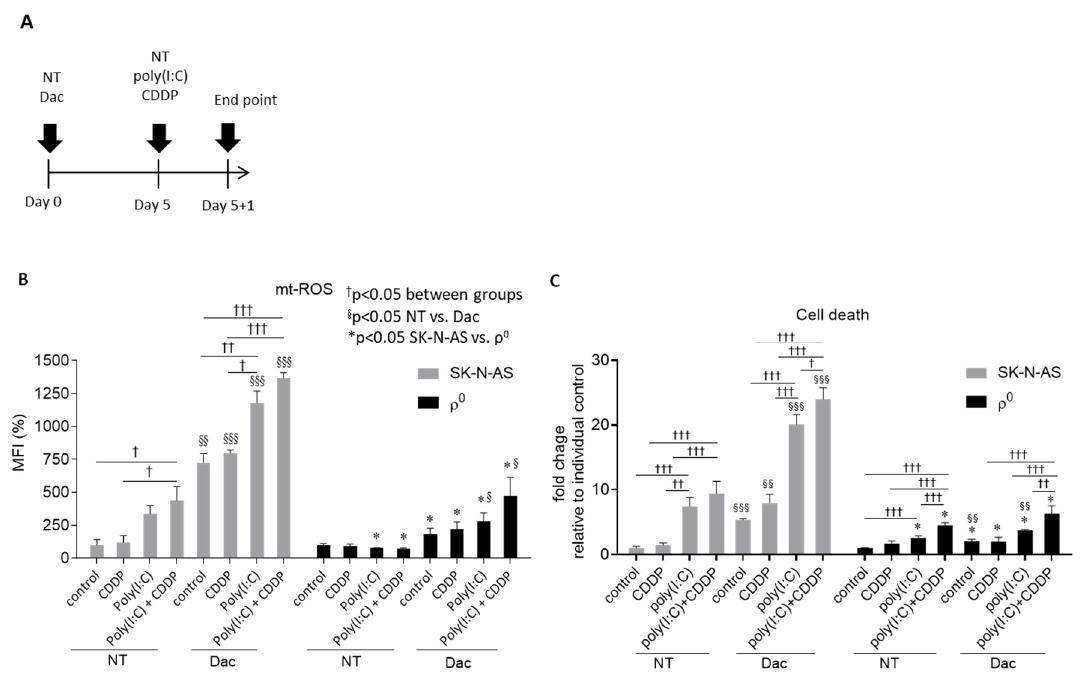
Figure 4. Dac potentiates mtROS-provoking and anti-NB e ff ect of CDDP and poly(I:C). ( A ) Experimental flow chart of drug combinations; ( B ) mitochondrial ROS (mtROS) probed by MitoSox TM Red staining and detected by flow cytometry; ( C ) cell death rate was detected using PI with flow cytometry. * p < 0.05 between SK-N-AS and ρ 0 cells. † p < 0.05, †† p < 0.01, ††† p < 0.001 between indicated groups. § p < 0.05, §§ p < 0.01, §§§ p < 0.001 between NT and Dac. NT—untreated; MFI—mean fluorescence intensity.